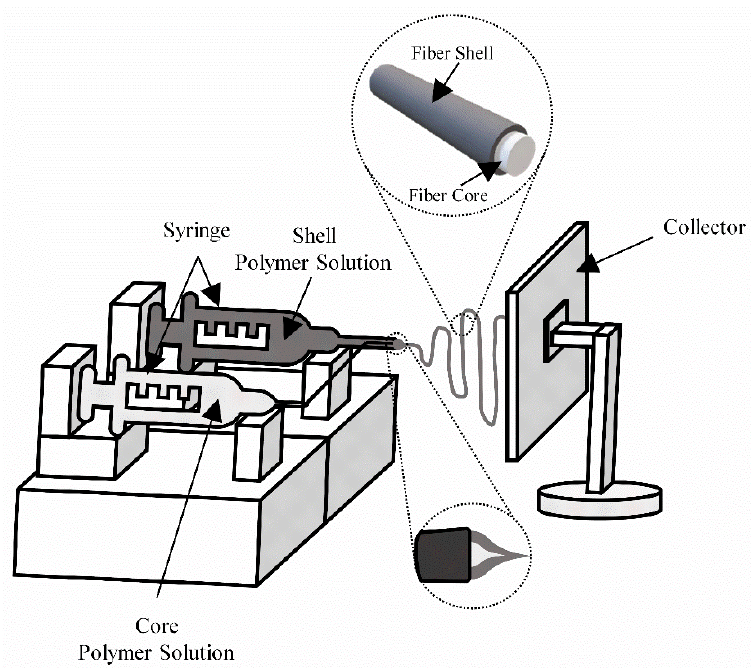
Figure 5. Core/shell electrospinning technique schema.